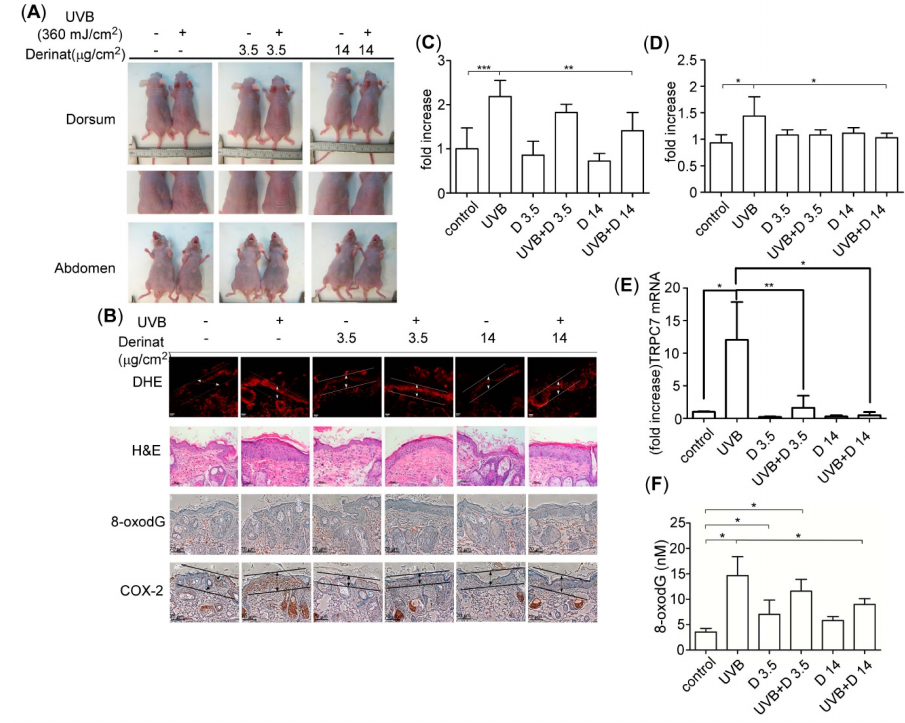
Figure 7. The effect of Derinat on UVB induced skin damage in BALB/c-nu mice. ( A ) BALB/c-nu mice were covered with Derinat hydrogel or pure hydrogel for 3 h and then irradiated with 360 mJ/cm 2 UVB. After seven days, the images of animals presented UVB-induced desquamation in the dorsal areas but no effect on the abdominal areas. The middle panel shows the amplified images from the dorsal areas of UVB-induced desquamation; ( B ) Derinat protected BALB/c-nu mice skin from UVB-induced epidermal proliferation, DNA damage and cyclooxygenase (COX)-2 expression. The skins of normal and UVB irradiated mice covered with Derinat hydrogel or hydrogel were stained with DHE and H & E (hematoxylin and eosin), and the oxidative DNA damage 8-oxodG was analyzed via an immunohistochemical assay with a specific anti-8-oxodG mouse monoclonal antibody. The expression of COX-2 in the epidermis was detected with an anti-COX-2 rabbit monoclonal antibody; ( C , D ), the quantification of intracellular ROS production and COX-2 level from ( B ) shown in arroew indicated region includes both epidermis and dermis without sebaceous glands ( * , p < 0.05; ** , p < 0.01; *** , p < 0.001). Derinat decreased the UVB-induced level of TRPC7 ( E ) and DNA damage 8-oxodG ( F ) in BALB/c-nu mouse skin based on qRT–PCR and ELISA assay, respectively ( * , p < 0.05; ** , p <